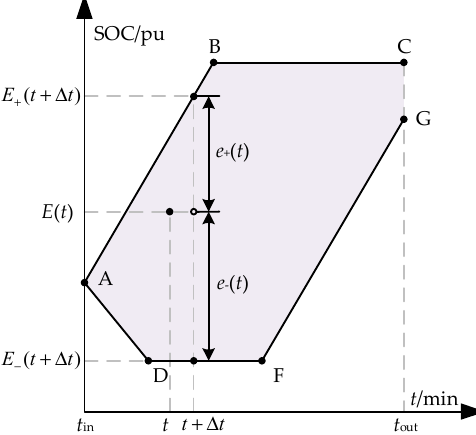
Figure 4. Schematic illustration of charging power range determination method for a controllable EV.